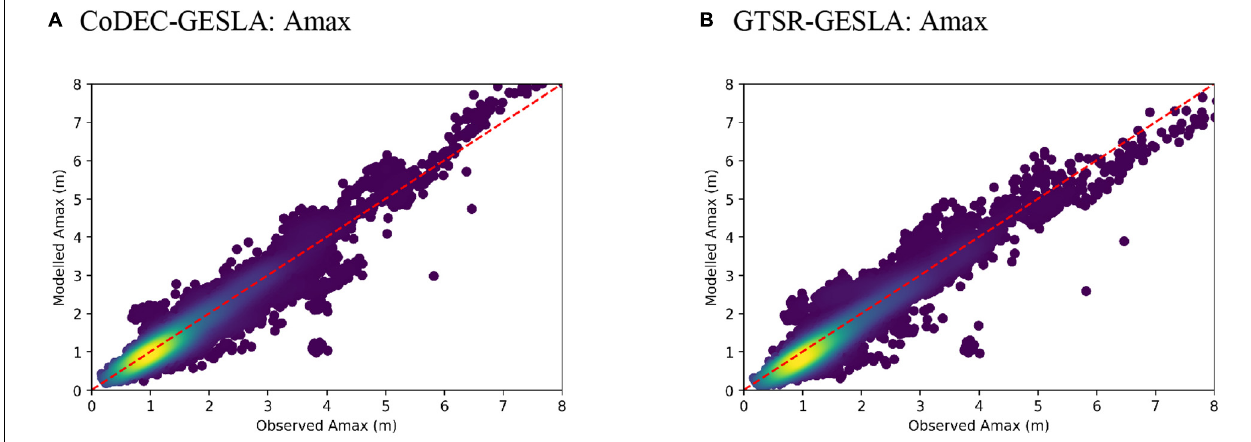
FIGURE 3 | Scatter density plots of the modeled and observed annual maxima (Amax) for the GESLA dataset for (A) the CoDEC-ERA5 dataset, and (B) the GTSR dataset. The data for all the tide gauge stations were combined. The red dotted line indicates the perfect fit line.